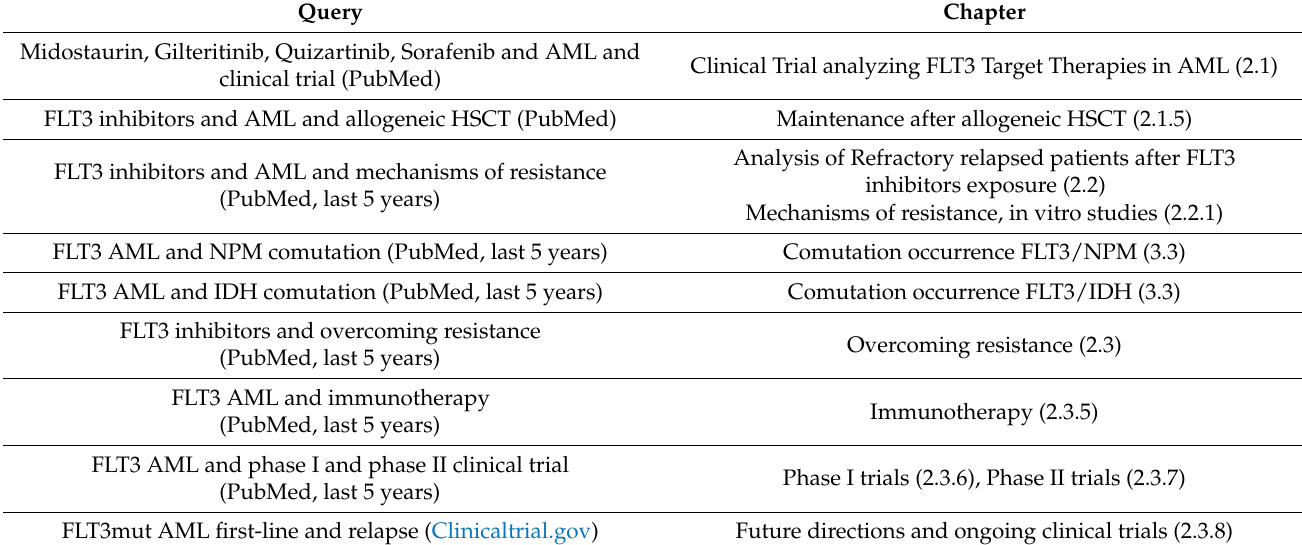
Table 1. List of queries performed for the selection of papers and clinical trials in the different chapters. Query Chapter Clinical Trial analyzing FLT3 Target Therapies in AML (2.1) clinical trial (PubMed) Maintenance after allogeneic HSCT